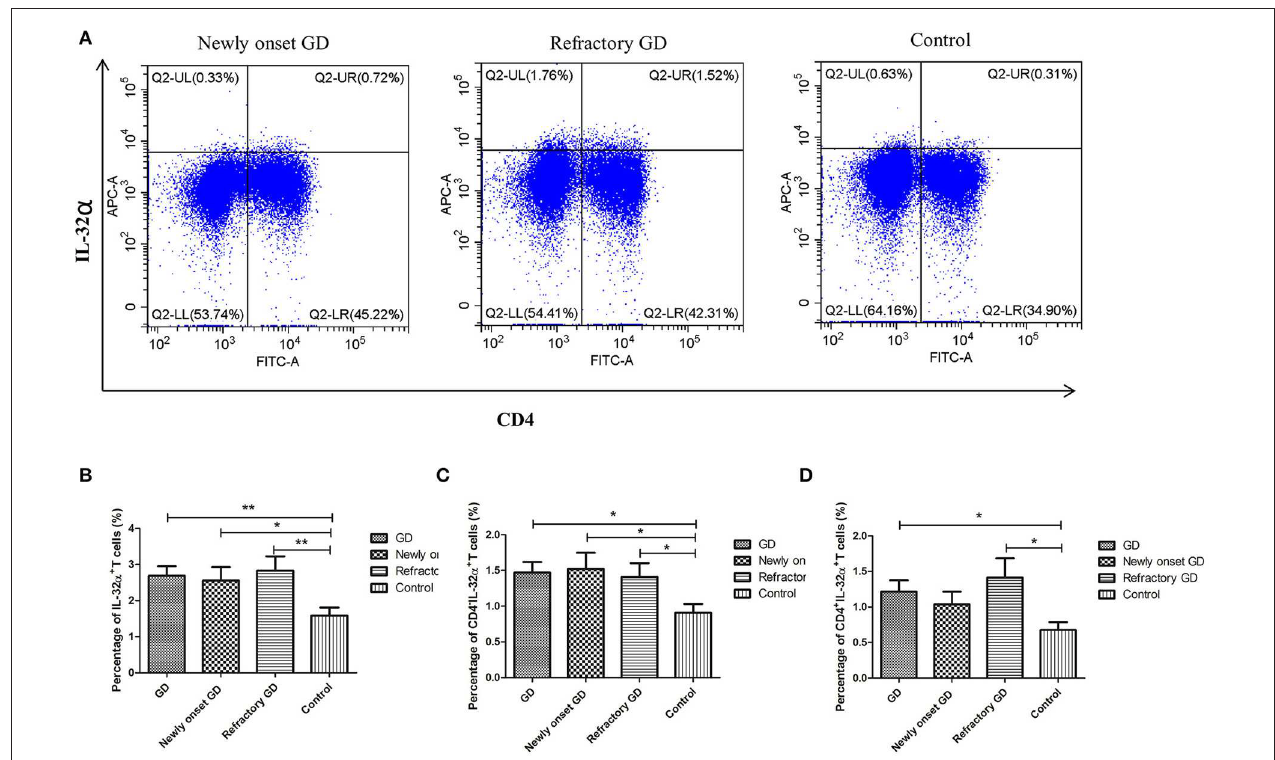
FIGURE 5 | Flow cytometric analysis detected IL-32 α + cells. (A) Representative flow cytometric data showing the expression of IL-32 α + cells in newly onset GD patients, refractory GD patients and controls. (B) The frequency of IL-32 α + cells in GD group, newly onset GDs group, refractory GD group and controls. (C) The frequency of CD4 − IL-32 α + cells in GD group, newly onset GDs group, refractory GD group and controls. (D) The frequency of CD4 + IL-32 α + T cells in GD group, newly onset GDs group, refractory GD group, and controls * P < 0.05, ** P <